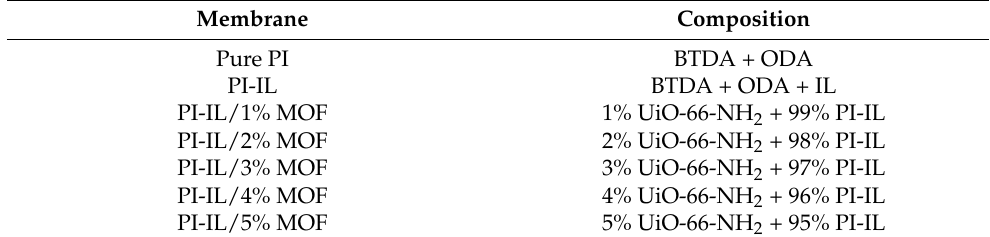
Table 1. Compositions of synthesized membrane.